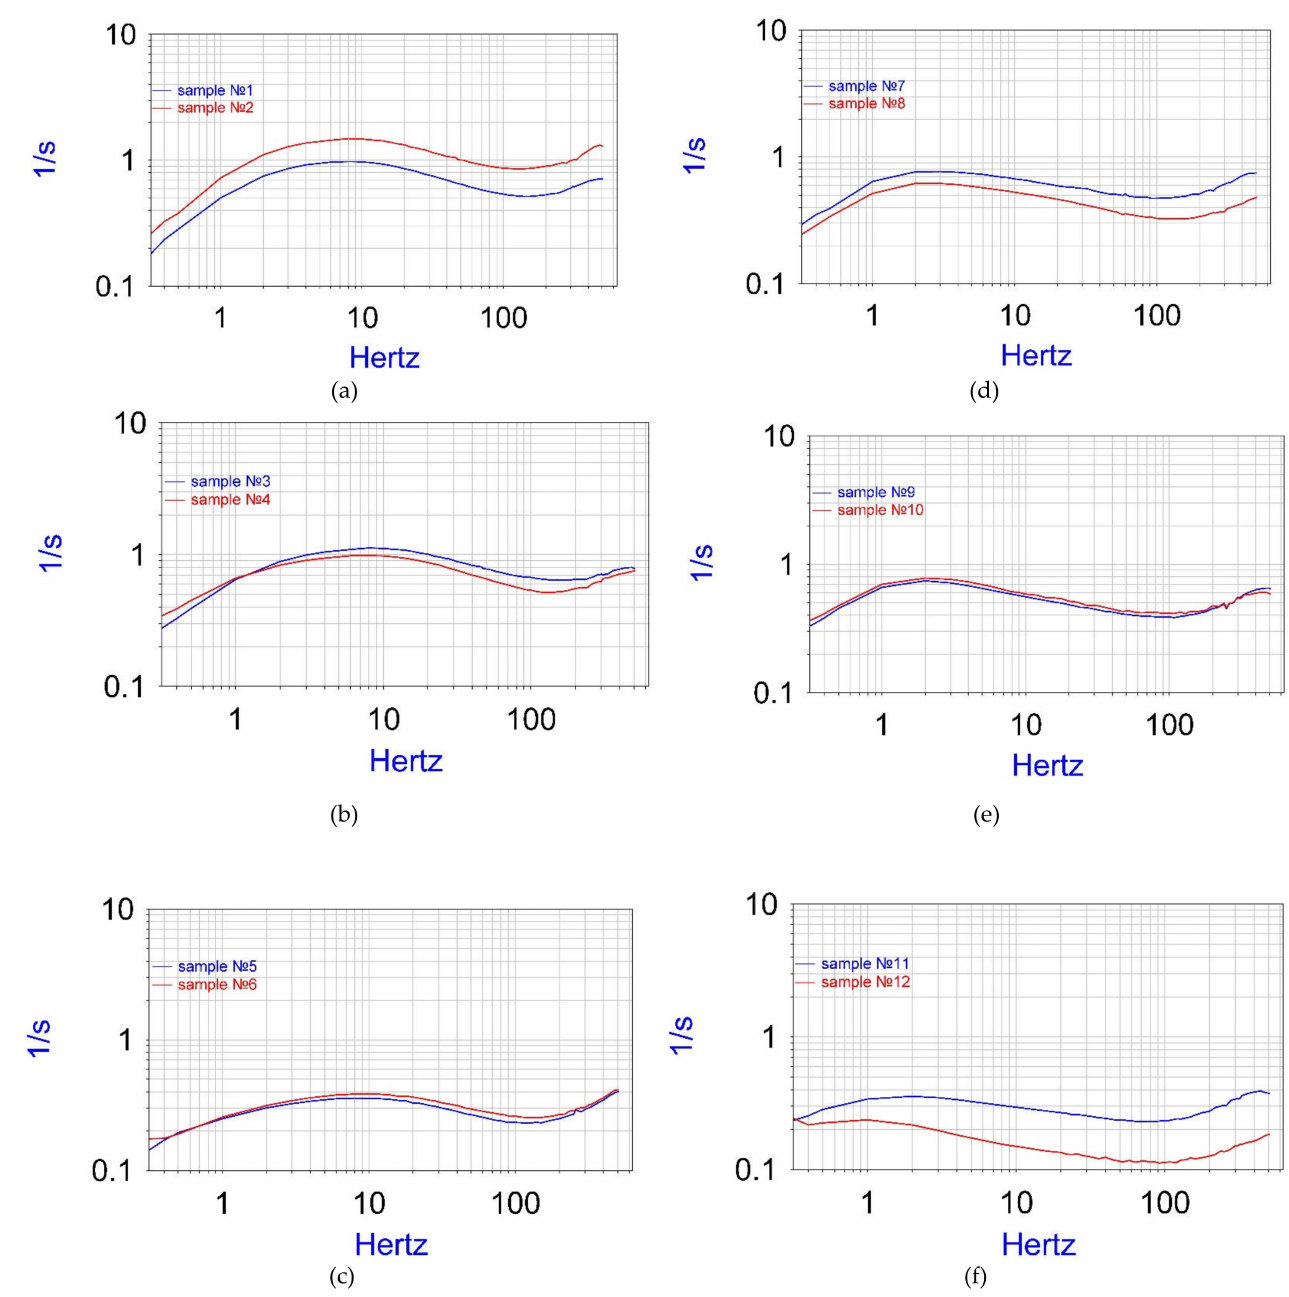
Figure 6. Amplitude vs. frequency curves for the experimental samples. Left side—configuration 1. Right side—configuration 2. From top to bottom ( top ): 2500 holes, ( middle ) 1600 holes, ( bottom ) 1024 holes. ( a ) samples 1 and 2; ( b ) samples 3 and 4; ( c ) samples 5 and 6; ( d ) samples 7 and 8; ( e ) samples 9 and 10; ( f ) samples 11 and